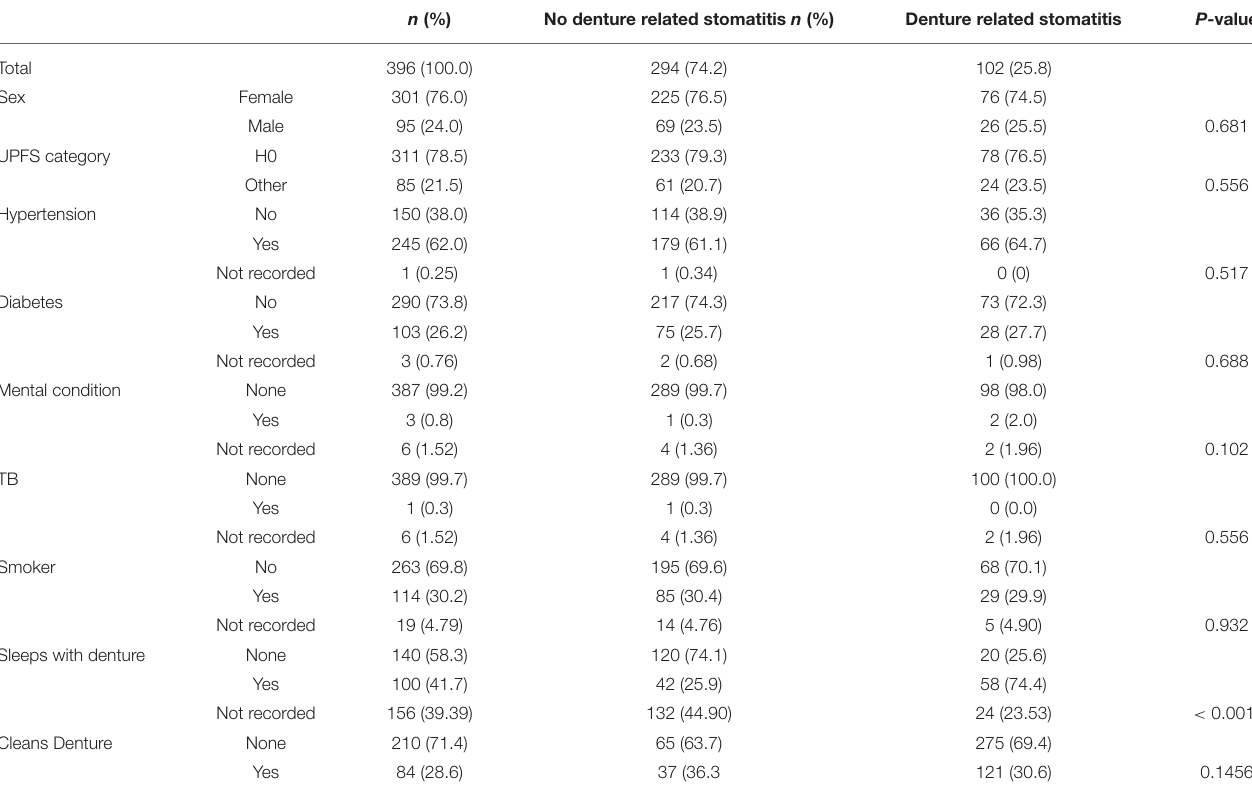
TABLE 1 | Distribution of demographic data of the patients. n (%) No denture related stomatitis n (%) Denture related